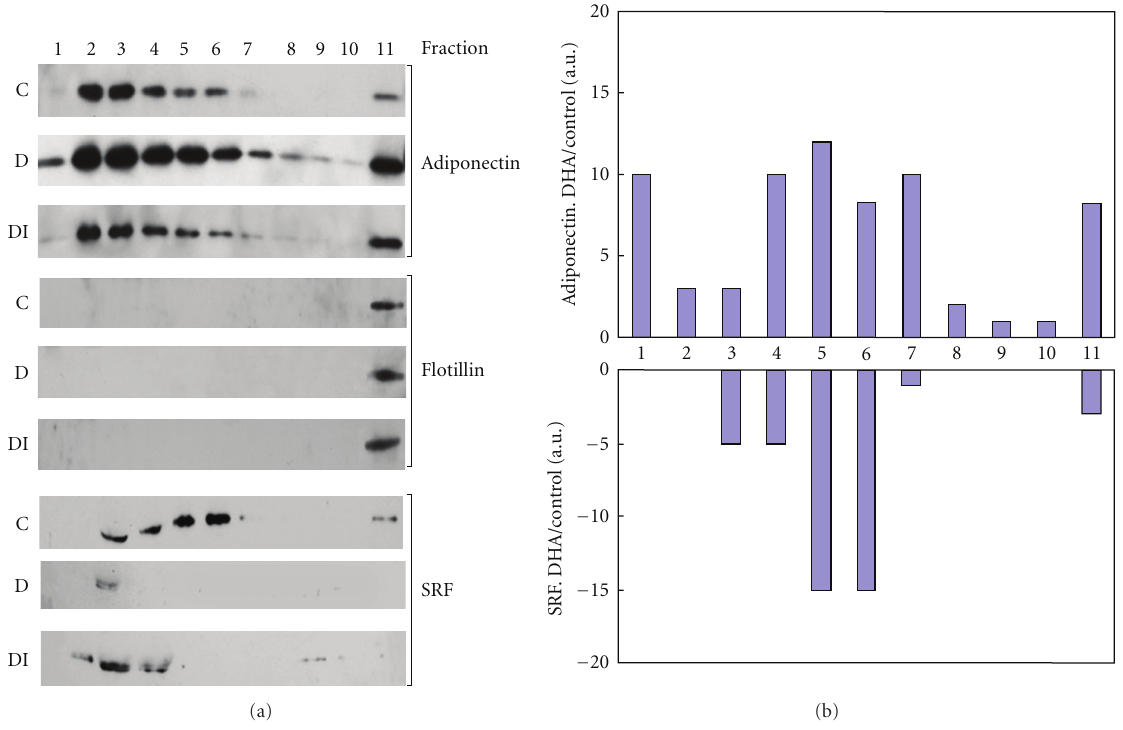
Figure 3: Fractionation of adipocyte medium following treatment with DHA or DHA in the presence of PPAR γ inhibitor GW 9662. Mouse adipocytes were treated : control (C), 25 μ M DHA (D), or 25 μ M DHA plus 1.5 μ M GW9662 (DI). Equal volumes of medium secreted from treatments were fractionated on sucrose gradients and separated into 11 equal fractions as described in Methods. (a) Equal volumes of each fraction were separated on SDS-PAGE gels and analyzed by Western blotting using adiponectin, Flotillin, or SRF antibody as described in Methods. (b) Bar graph represents densitometric analysis of change in adiponectin and SRF expression following DHA treatment in each fraction: